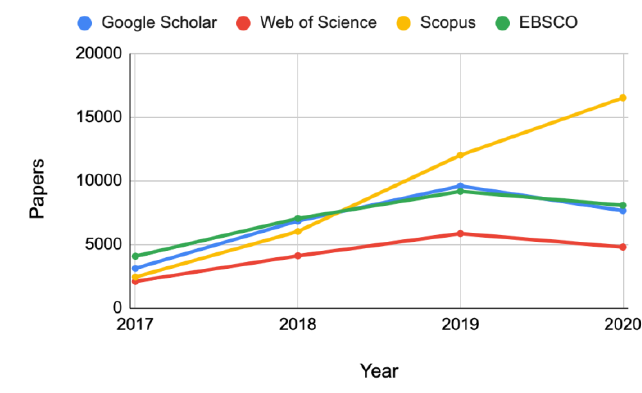
Figure 8: Blockchain-related papers published per year.